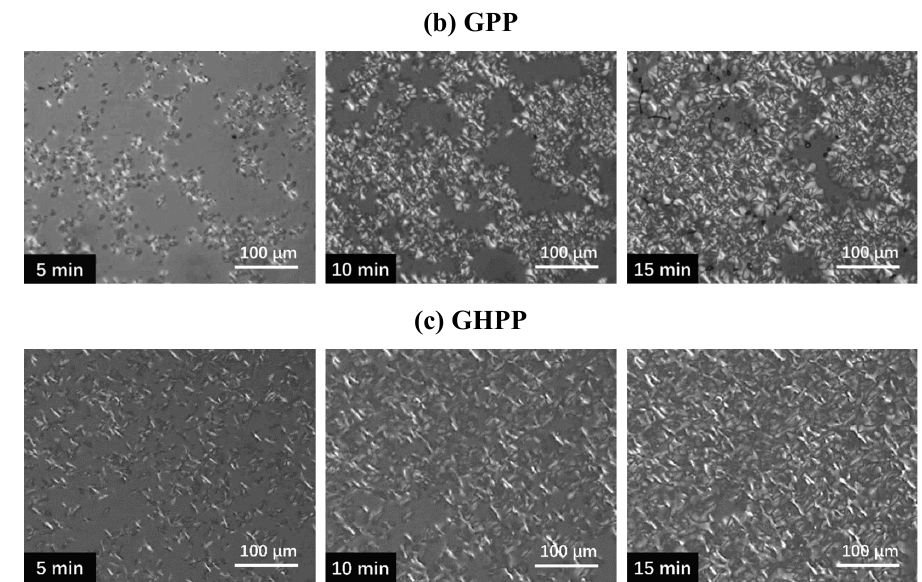
Figure 10. Polarized optical microscopy (POM) images during the isothermal crystallization at 130 °C of ( a ) neat PP, ( b ) GPP, and ( c ) GHPP.